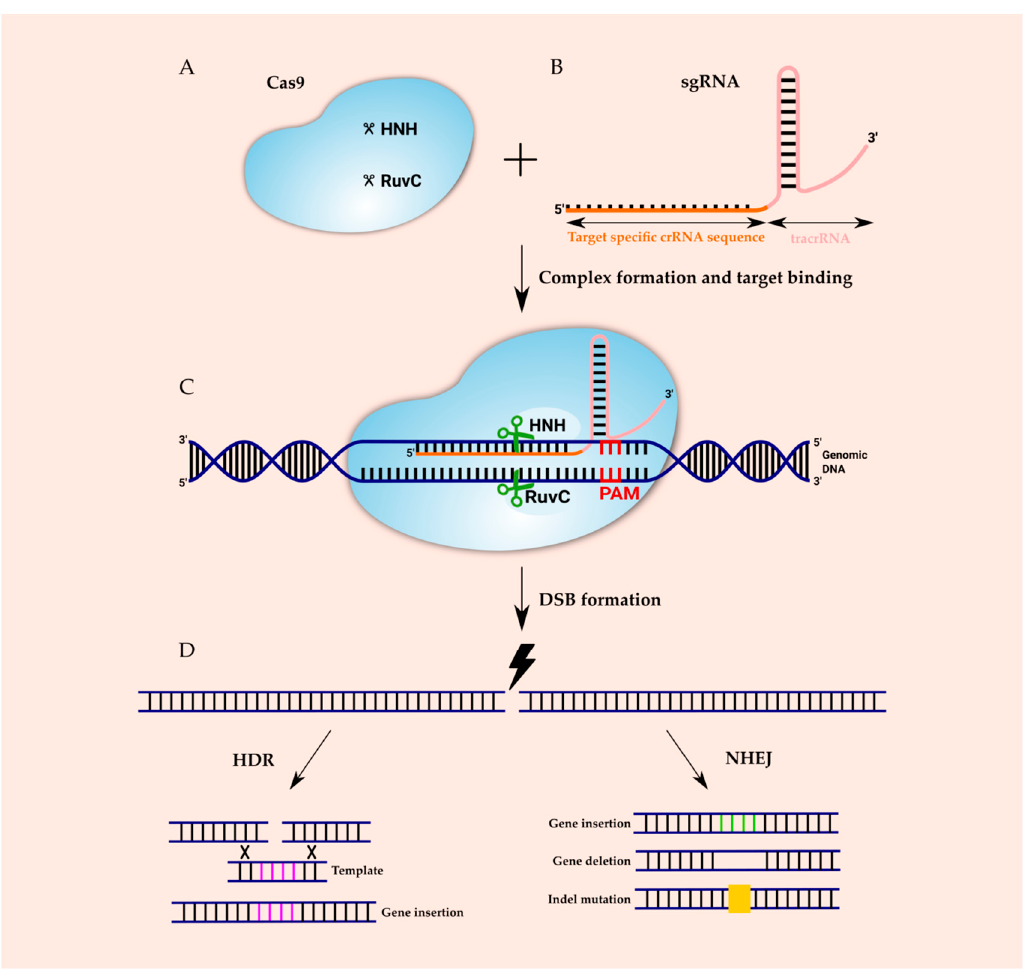
Figure 1. Schematic diagram of the CRISPR–Cas 9 system molecular mechanism. The CRISPR/Cas 9 system is composed of sgRNA and Cas9. The Cas9 protein contains two nuclease domains—the RuvC domain, which cleaves non-complementary DNA strands, and the HNH domain, which cleaves complementary DNA strands ( A ). The sgRNA includes the trans-activating crispr RNA (tracrRNA) and crispr RNA (crRNA). The crRNA comprises a 20 nt protospacer element and a few additional nucleotides, which are complementary to the tracrRNA ( B ). The tracrRNA hybridizes to the crRNA and binds to the Cas9 protein forming the CRISPR–Cas9/sgRNA complex in order to edit the genome sequences. The Cas9–sgRNA complex unwinds the dsDNA, and the complementary sequence in sgRNA anneals to one of DNA strands. Upon binding, the endonuclease domains cleave both DNA strands three bases upstream of the protospacer-adjacent motif (PAM) sequence ( C ). The double-strand break (DSB) in DNA forms and then is repaired either by a homology directed repair (HDR) pathway, if an appropriate donor is present, or by non-homologous end joining (NHEJ). HDR repair allows precise genome editing at the target site, and NHEJ introduces short insertions, deletions or indels ( D ).